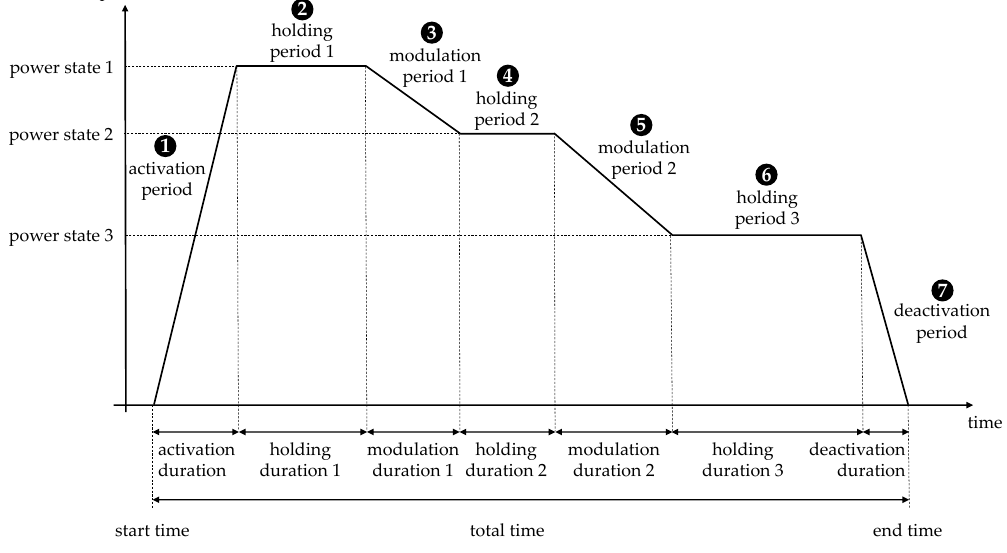
Figure 3. An exemplary flexible load measure with the corresponding